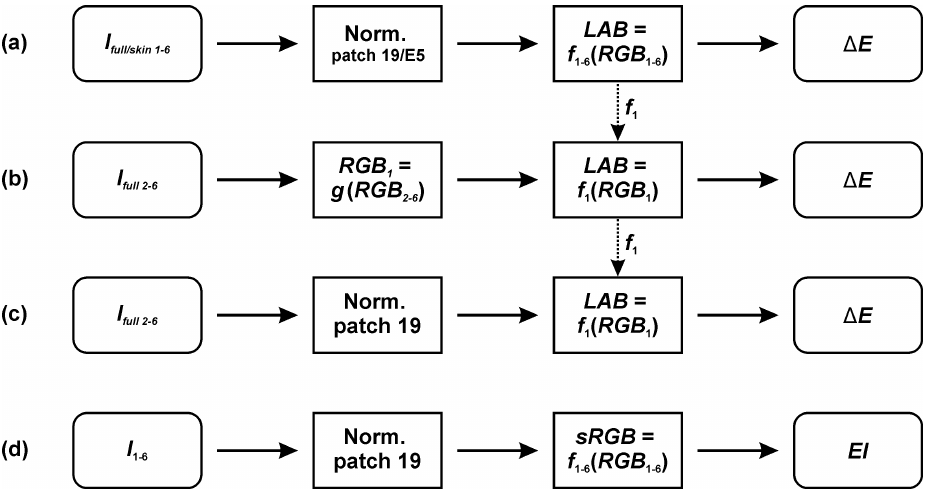
Figure 3. Flowcharts of different color calibration procedures. ( a ) Image sets ( I full/skin 1–6 ) of the selected CCT color patches were acquired and normalized against patches 19 (full-range CCT) or E5 (skin-range CCT). For each set independently, we built a transformation model between an unknown RGB and a standard CIELAB color space ( LAB = f ( RGB )). ( b ) Full normalization. RGB values of I 2–6 were first transformed to the RGB color space of I 1 and later to the CIELAB based on the known f 1 . ( c ) Single-point normalization. Normalized images ( I 2–6 ) with the brightest patch (No. 19) were directly transformed to the CIELAB color space based on the known f 1 . ( d ) Erythema Index (EI) was calculated after the colorimetric data was transformed to the standard RGB color space (sRGB).